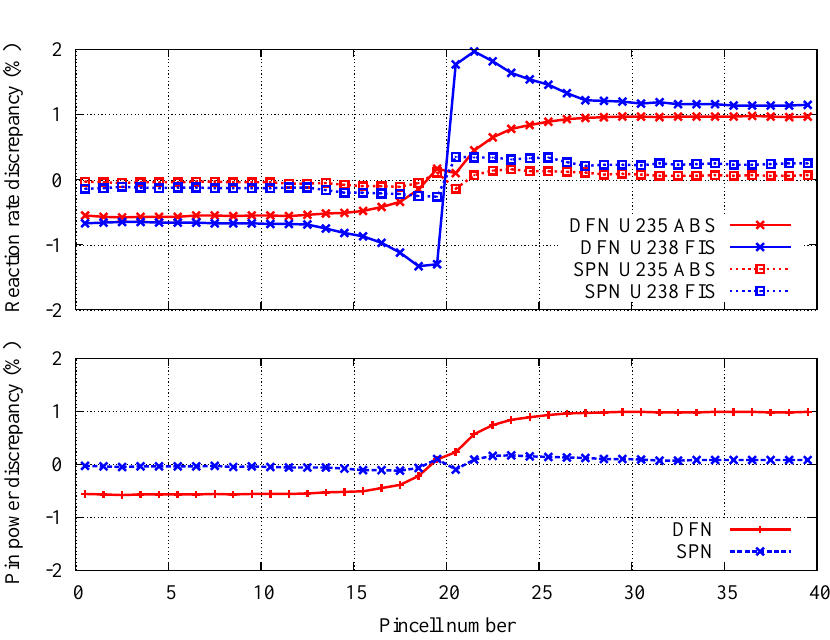
Figure 1: Reaction rate and pin power differences relative to a CACTUS reference, for PANTHER pin-by-pin diffusion (DFN) and SPN-corrected